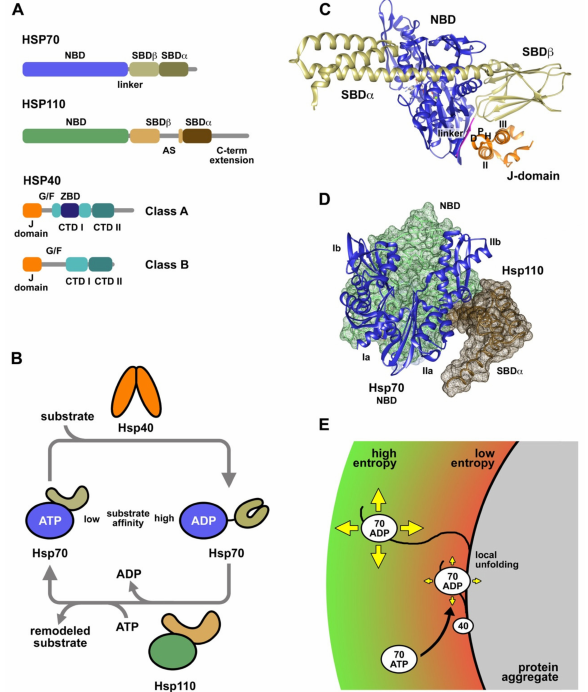
Figure 1. Human chaperones involved in proteostasis and reactivation of protein aggregates. ( A ) Schematic representation of the domain organization of the main proteins comprising the human disaggregase: Hsp70, Hsp110, and Hsp40 (Classes A and B). Proteins and domains are drawn on scale according to the length of their amino acid sequences. ( B ) ATPase and conformational cycle of Hsp70 essential to the chaperone activity. Substrates enter the cycle by binding to Hsp40 and then, they are transferred to the ATP-bound state of Hsp70. Both, the Hsp40 cochaperone and the substrate stimulate ATP hydrolysis, closing the SBD and trapping the substrate in the ADP-state. Hsp110 interacts with the NBD of the chaperone and promotes exchange of ADP by ATP, which triggers the dissociation of the Hsp70-client complex and thus, the release of the substrate. ( C ) Ribbon representation of full-length E. coli Hsp70 (DnaK) in complex with the J-domain of DnaJ (PDB ID:5NRO; [31]) using UCSF Chimera [32]. ( D ) Structure of the human Hsp70 NBD in complex with Saccharomyces cerevisiae Hsp110 (PDB ID:3D2F) [33]. ( E ) Entropic pulling model proposed to act during protein aggregate solubilization by the Hsp70-system. Hsp40 recruits Hsp70 to the aggregate surface, which results in a reduction of its entropy. Local unfolding of the bound polypeptide might allow the movement of the Hsp70-client complex away from the aggregate surface, incrementing the degrees of freedom of the molecules. This would generate a favorable free energy change ( ∆ G < 0) due to the local entropy